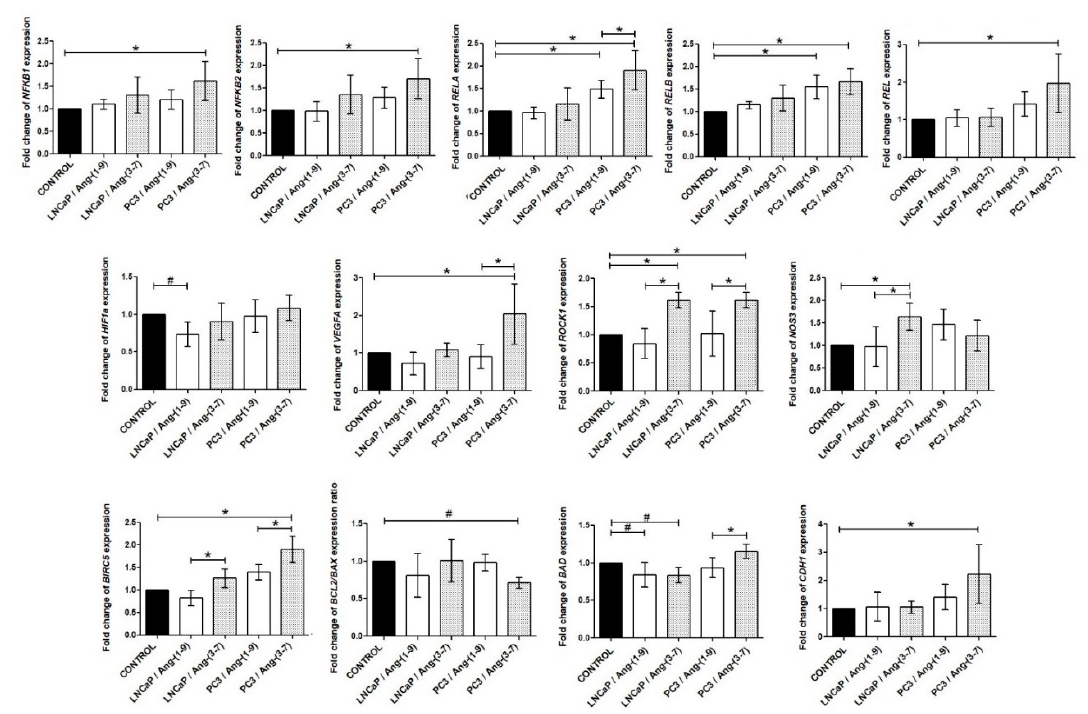
Figure 7. RT-qPCR analysis of the expression of inflammatory and apoptotic pathway genes in the prostate cancer lines (LNCaP and PC3) after exposure to Ang-(1-9) or Ang-(3-7) at a concentration of 1 nM for 48 h (mean ± SEM; Tukey’s test: * p < 0.05; Dunnett’s test: # p < 0.05).